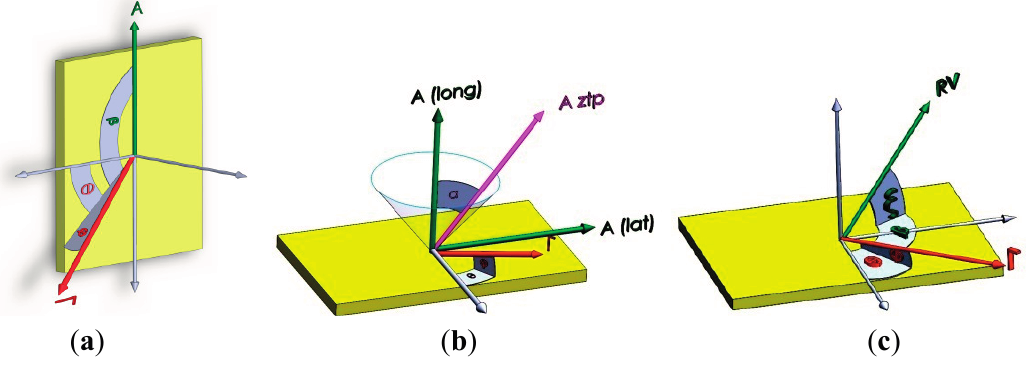
Figure 3. Clock bias sources for reference oscillators of highly dynamic receivers.